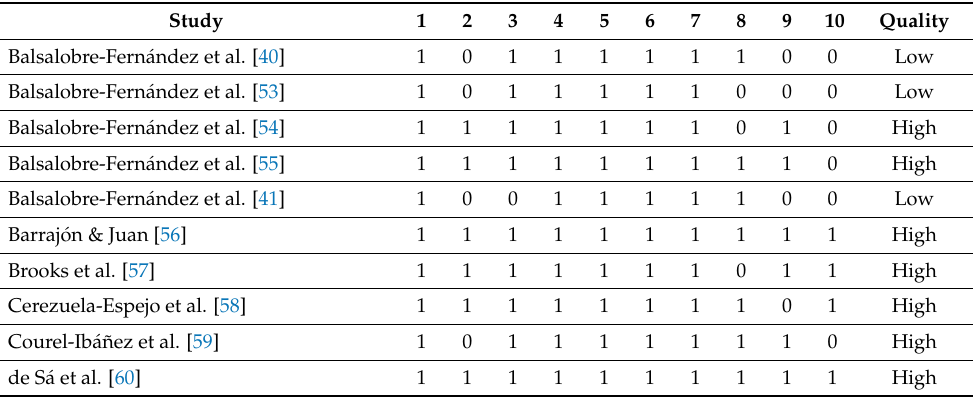
Table 2. Methodological assessment of the included